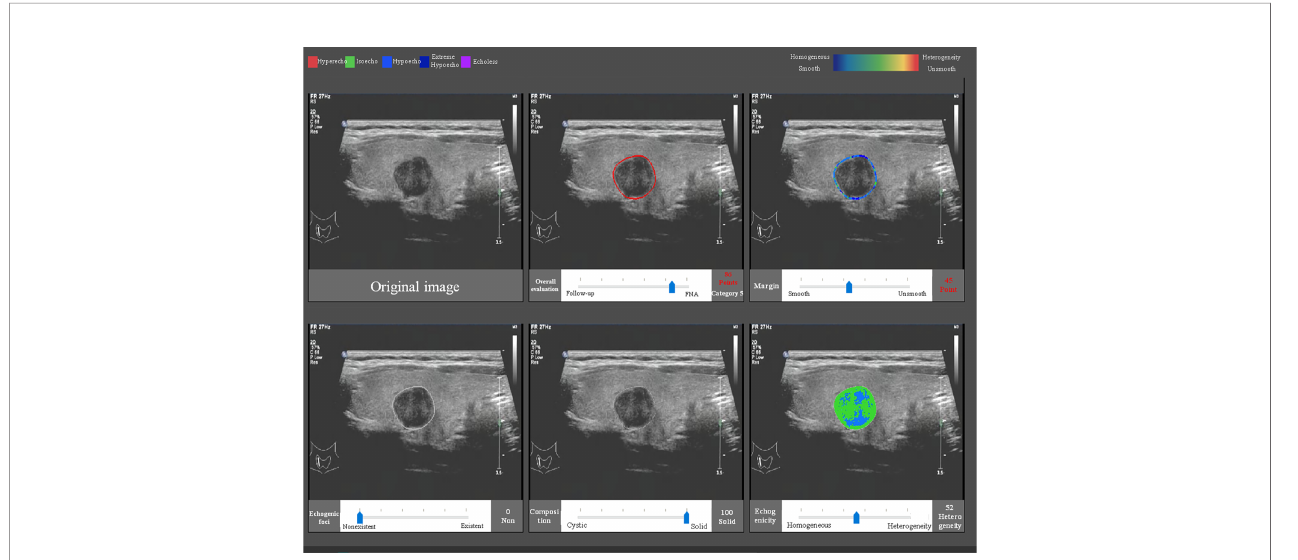
FIGURE 1 | The CAD interface for detection and diagnosis of thyroid nodules. Upper row (from left to right): original image, overall evaluation (score and category), and margin (score and category). Bottom row (from left to right): echogenic foci (percentage and classi fi cation), composition (percentage and classi fi cation), and echogenicity (percentage and classi fi